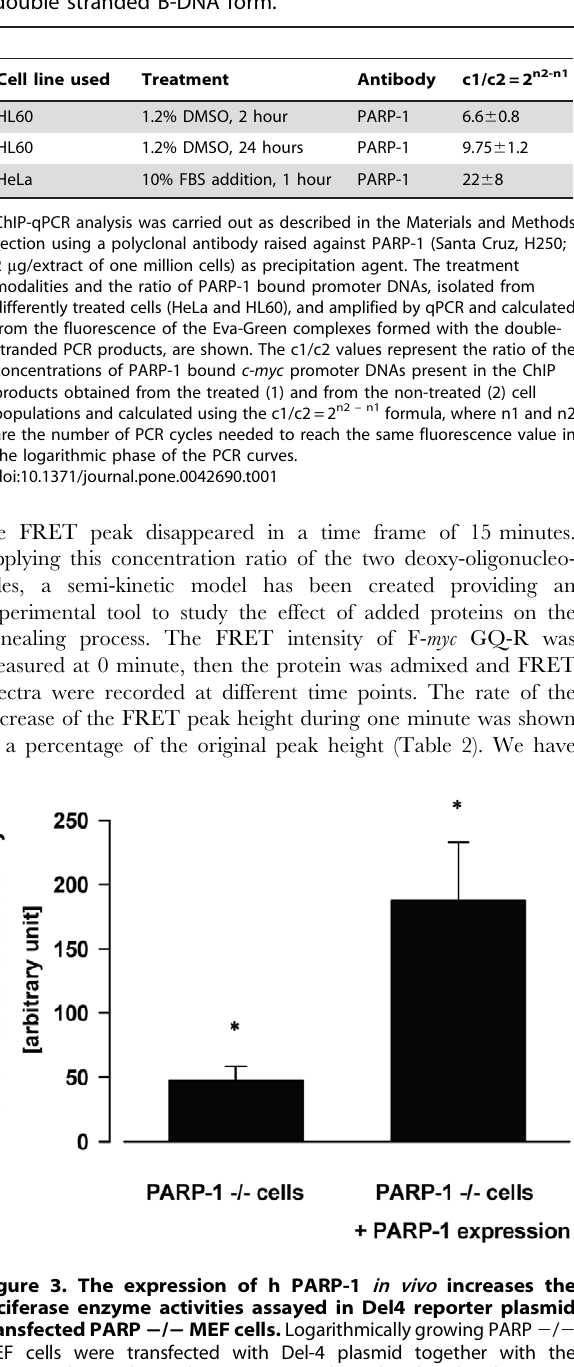
Table 1. ChIP-qPCR analysis of in vivo binding of h PARP-1 to the NHE III 1 region present in the promoter of the h c-myc gene, and which is presumably either in the GQ form or in the double stranded B-DNA form.